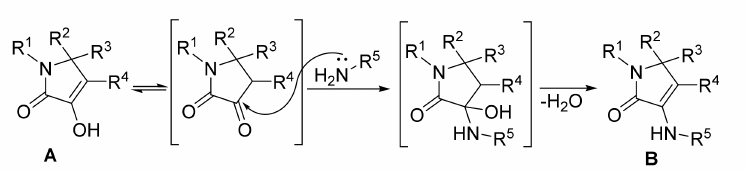
Scheme 4. Proposed mechanism of the reaction for HDPs A with